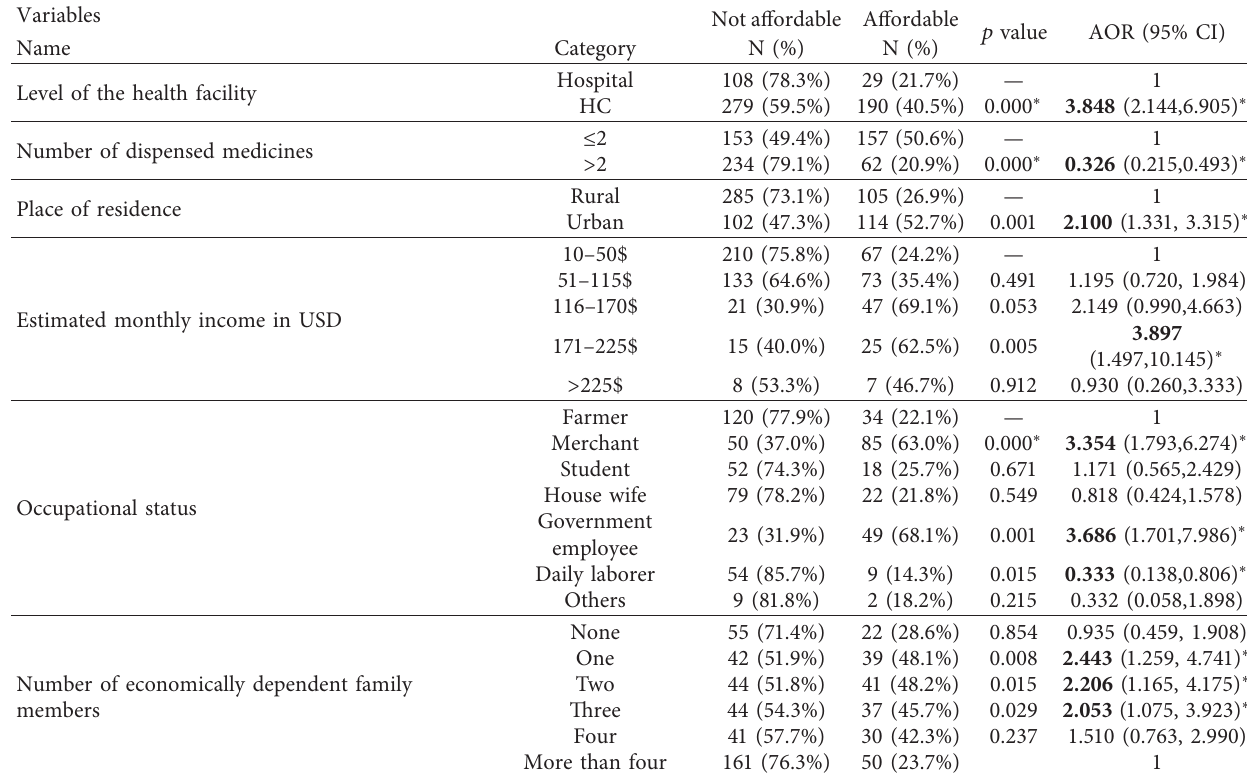
Table 4: Multivariable logistic regression analysis of factors associated with perceived affordability of essential medicine in public health facilities of the Jimma